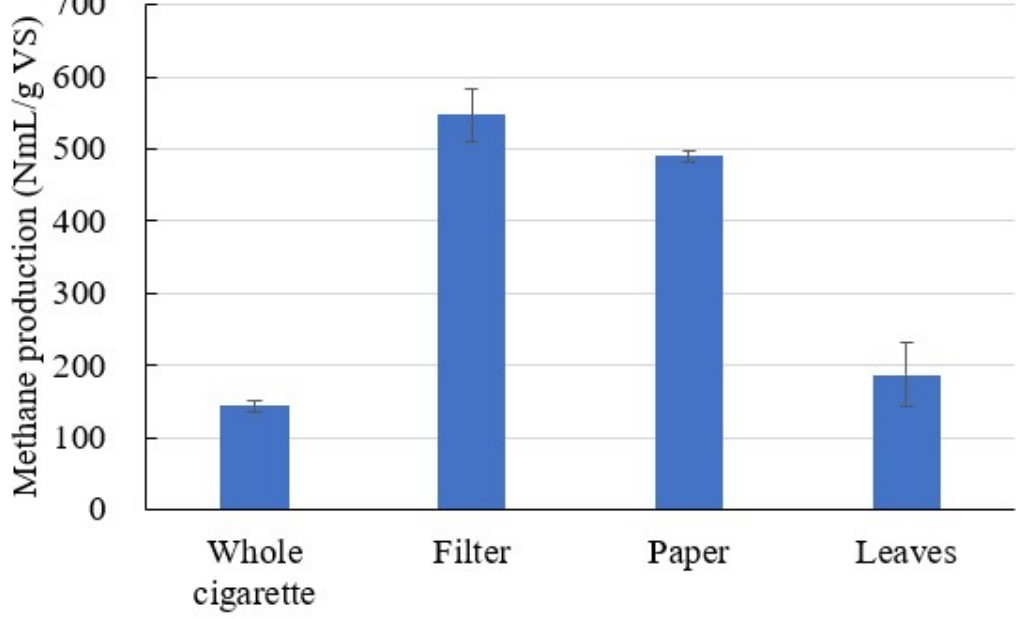
Figure 2. Amount of methane produced by each component of cigarette butts. Methane production was normalized using the division by volatile solids (VS). Table 1. Results of anaerobic digestion using cigarette butts or individual components and kinetic parameters calculated from the modified Gompertz model. All data are expressed as mean ± standard deviation.